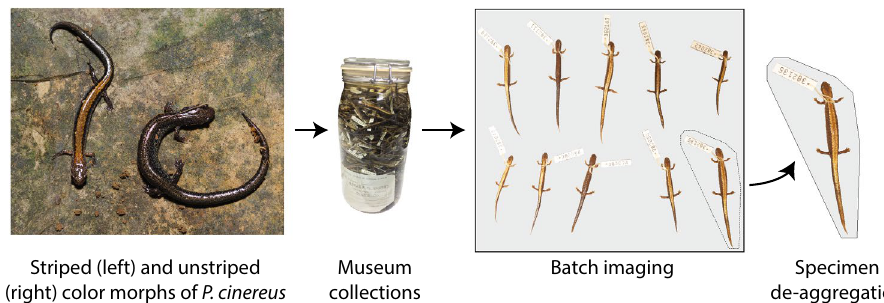
Figure 1. Methodological workflow: striped and unstriped morphs of Plethodon cinereus were collected by Richard Highton and deposited into the National Museum of Natural History (NMNH); batch imaging of salamanders (dorsal view) was carried out at the NMNH; subsequently, we de-aggregated specimens from the original image. Individual specimen images were then uploaded to the web-based community science platform Notes from Nature 52 , where volunteers scored color